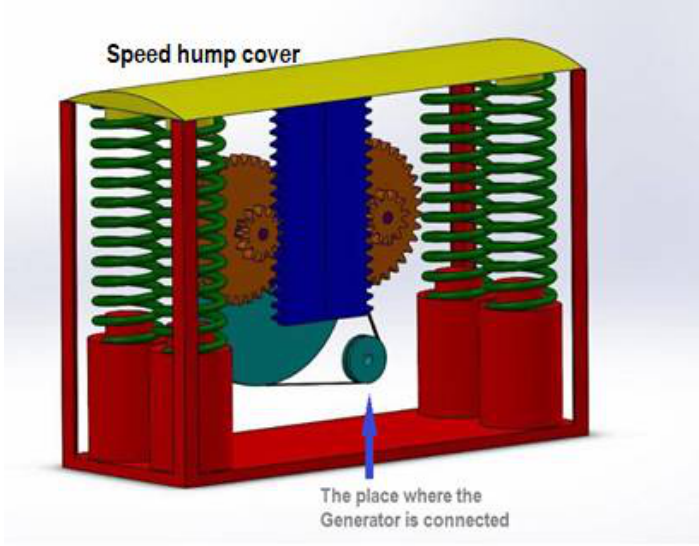
Figure 3. A section of the speed hump system.